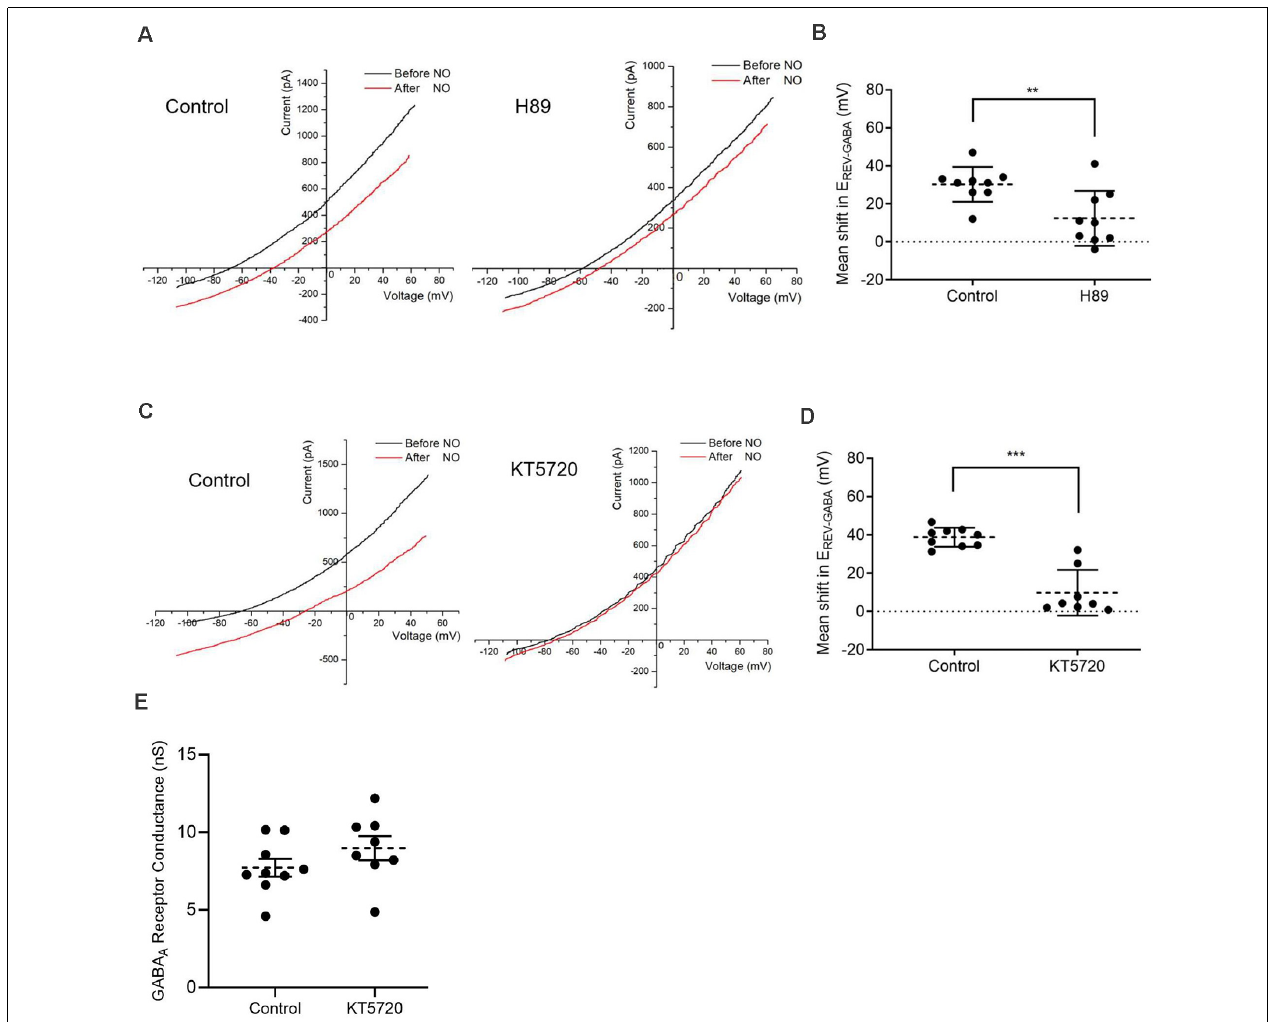
FIGURE 4 | PKA activity is required for the NO-dependent shift in E REV-GABA . (A) Date from cells recorded under control condition (left) or pre-incubated with a kinase inhibitor, H89 (1 µ M) for 30 min (right) that suppresses the NO-dependent shift in E REV-GABA . (B) The quantified mean shift in E REV-GABA ± SEM; n = 9. ** P < 0.01 (unpaired t -test). (C) Pre-incubation with selective PKA inhibitor, KT5720 (300 nM, 20 min), also reduces E REV-GABA. (D) The quantified mean shift E REV-GABA ± SEM; control, n = 9; KT5720, n = 8. *** P < 0.001 (Welch’s unpaired t -test). (E) The quantified mean GABA A receptor conductance ± SEM; control, n = 9; KT5720, n = 8. P = 0.2057 (unpaired t